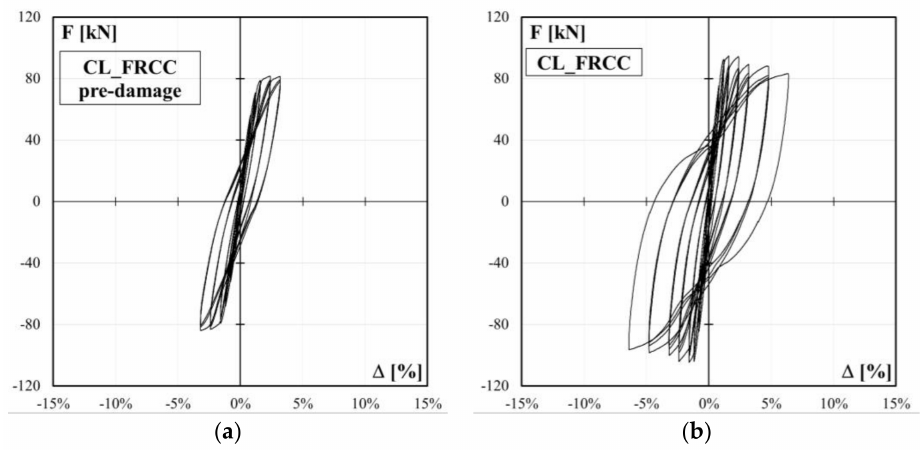
Figure 9. Force-drift curve for specimen CL_FRCC: ( a ) pre-damage; ( b ) after